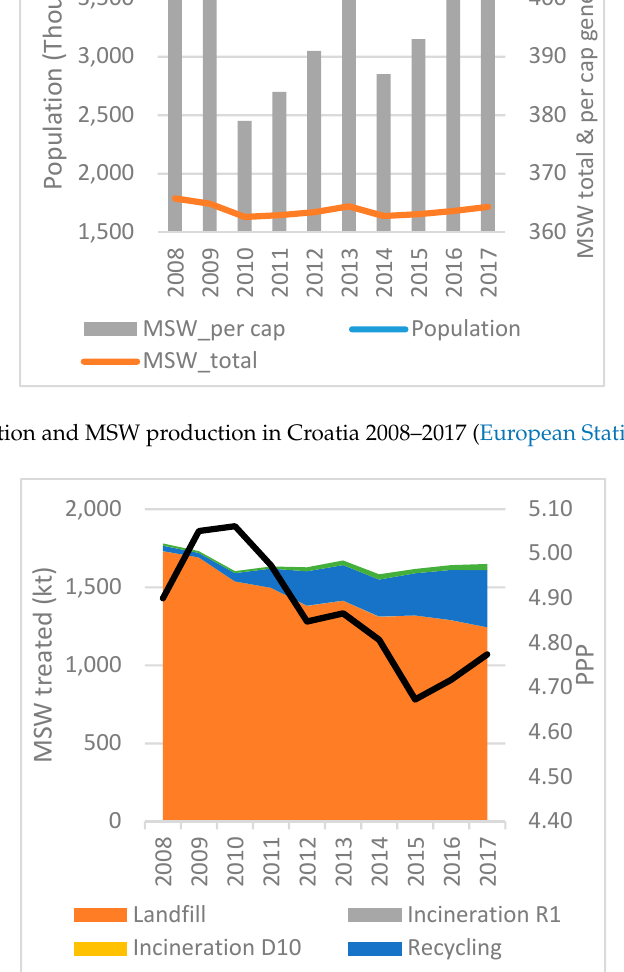
Figure 23. Population and MSW production in Italy 2008–2017 (EUROSTAT 2019a, 2019c).